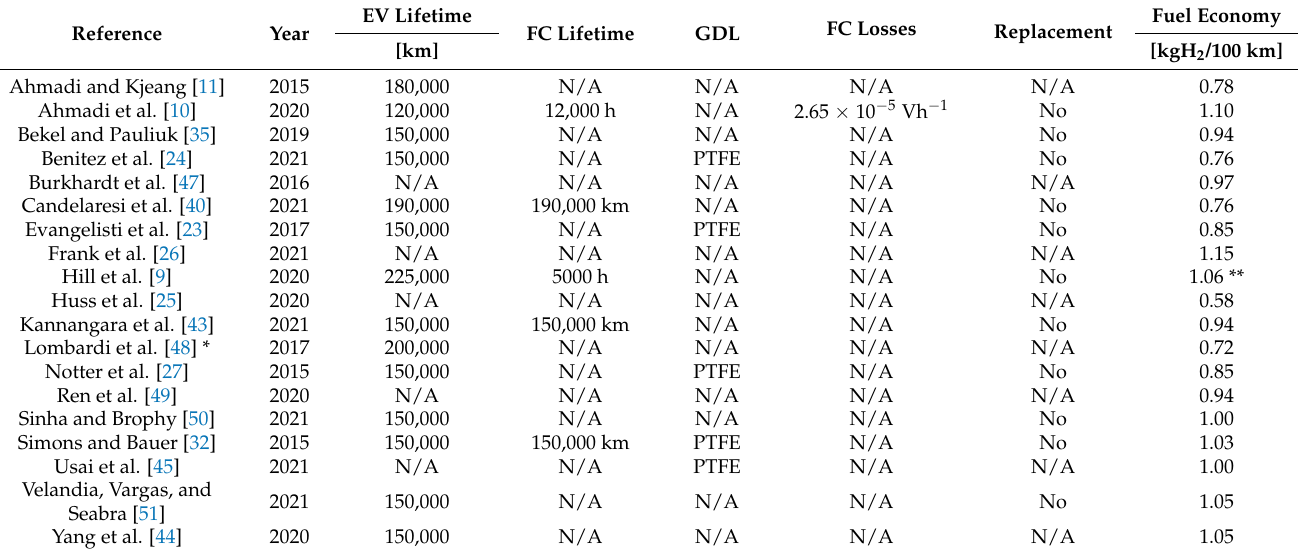
Table 3. Literature review results. * Plug-in hybrid fuel cell battery vehicle. ** The value has been recently updated to 0.91